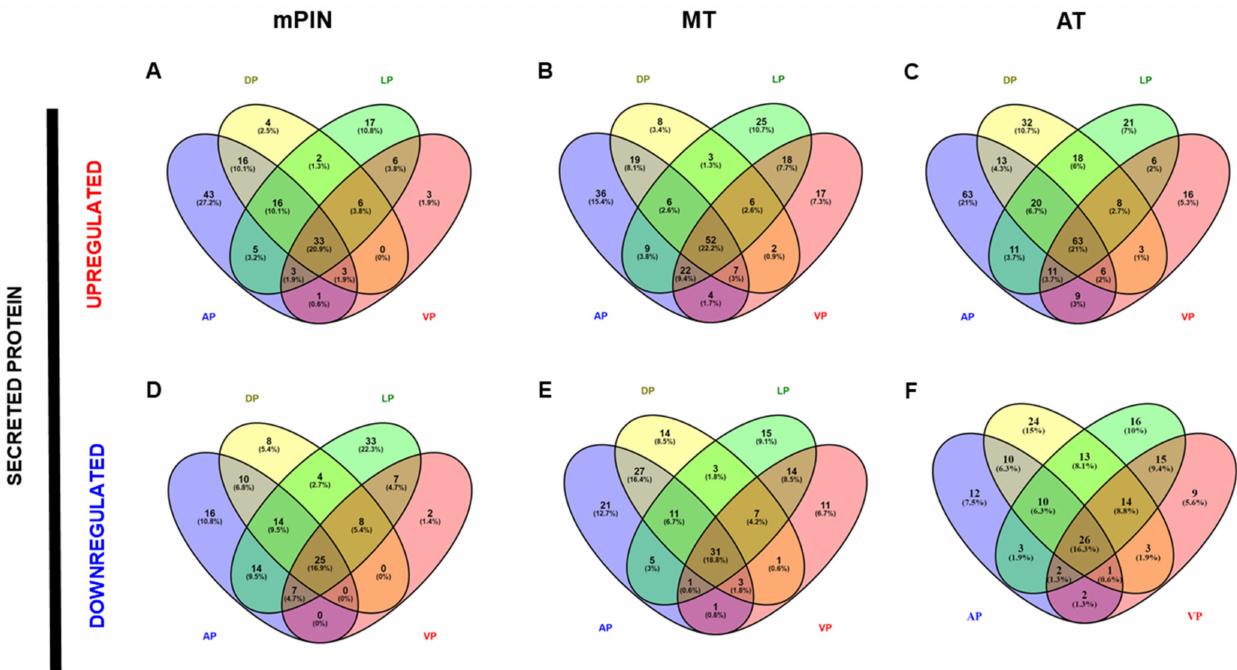
Figure 3. Venn’s diagrams depicting common genes of secreted proteins from Anterior Prostate (AP), Dorsal Prostate (DP), Lateral Prostate (LP), and Ventral Prostate (VP) PCa in Pten knockout mice. Venn’s diagrams of exclusive Upregulated genes in mPIN ( A ), MT ( B ), and AT ( C ), and downregulated genes in mPIN ( D ), MT ( E ), and HT ( F ). mPIN = mouse Prostatic Intraepithelial Neoplasia. MT = Middle-stage tumor. AT = Advanced-stage tumor.